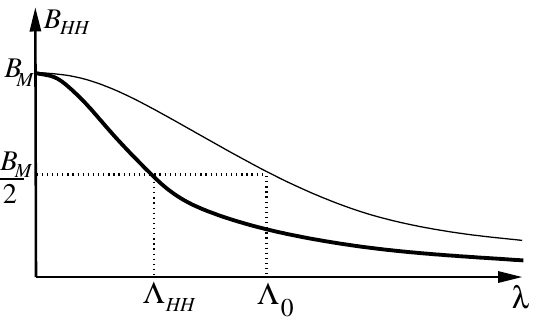
Figure 11. Suppression of the decay rate of the Hartle-Hawking vacuum as a function of the BH temperature T = λ/ (2 π ) (thick line). Transition between the low- and high-temperature BH regimes occurs at Λ given by eq. (5.6). The tunneling suppression in flat spacetime at the same HH temperature is shown with the thin line (cf. figure 8). For Λ